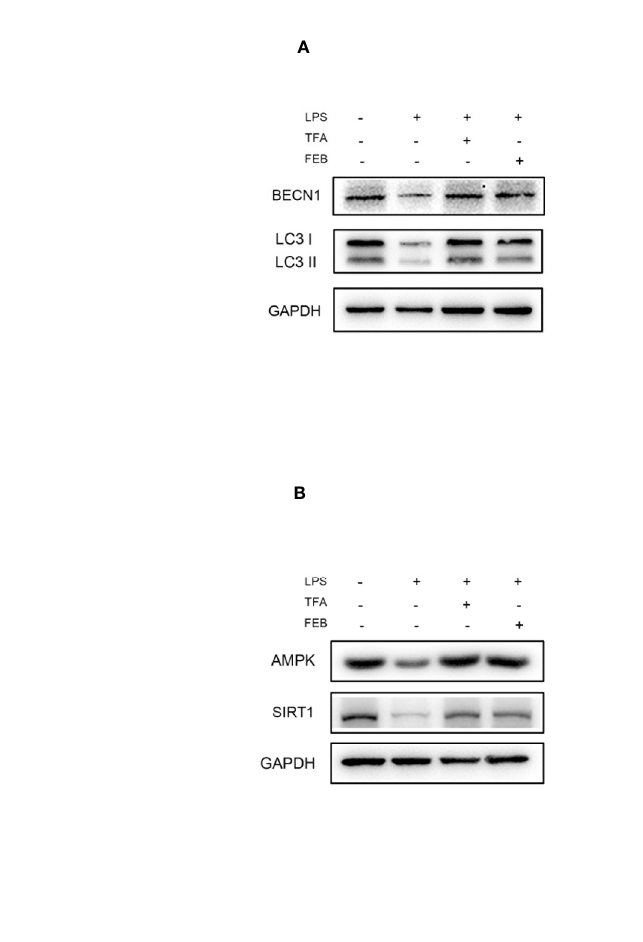
FIGURE 8 | Effects of TFA and FEB on autophagy-mediated macrophage polarization through AMPK-SIRT1 signaling in vitro . (A) A WB analysis of BECN1 and LC3 in RAW 264.7 cells exposed to LPS (100 ng/ml) with or without TFA (20 m g/ml) or FEB (100 nM) for 24 h. (B) A WB analysis of AMPK, and SIRT1 in RAW 264.7 cells exposed to LPS (100 ng/ml) with or without TFA (20 m g/ml) or FEB (100 nM) for 24 h. The data are expressed as the mean ± SD, (n = 3). * P < 0.05, ** P < 0.01. TFA, total fl avones of Abelmoschus manihot ; FEB, febuxostat; BECN1, beclin1; LPS, lipopolysaccharide; NS, not signi fi cant; WB, Western